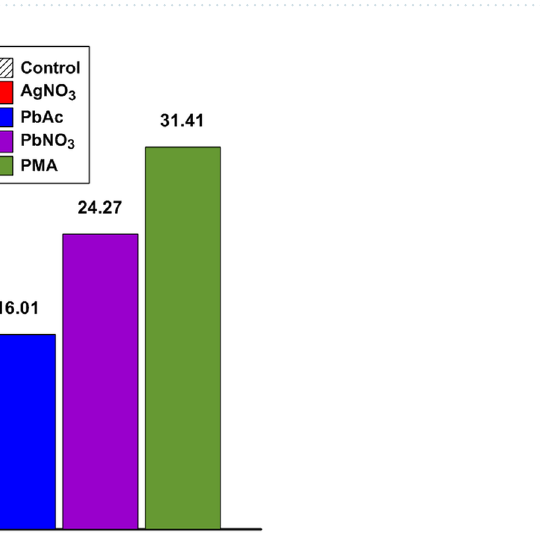
Figure 4. Two dimensional grey scale image representing a horizontal slice of the fine sand + clay + POM mixtures: the control treatment and the stained AgNO 3 , PbAc, Pb(NO 3 ) 2 and PMA treatments (image contrast was enhanced in this figure). Clusters of stained clay particles are clearly observable as brighter structures in the AgNO